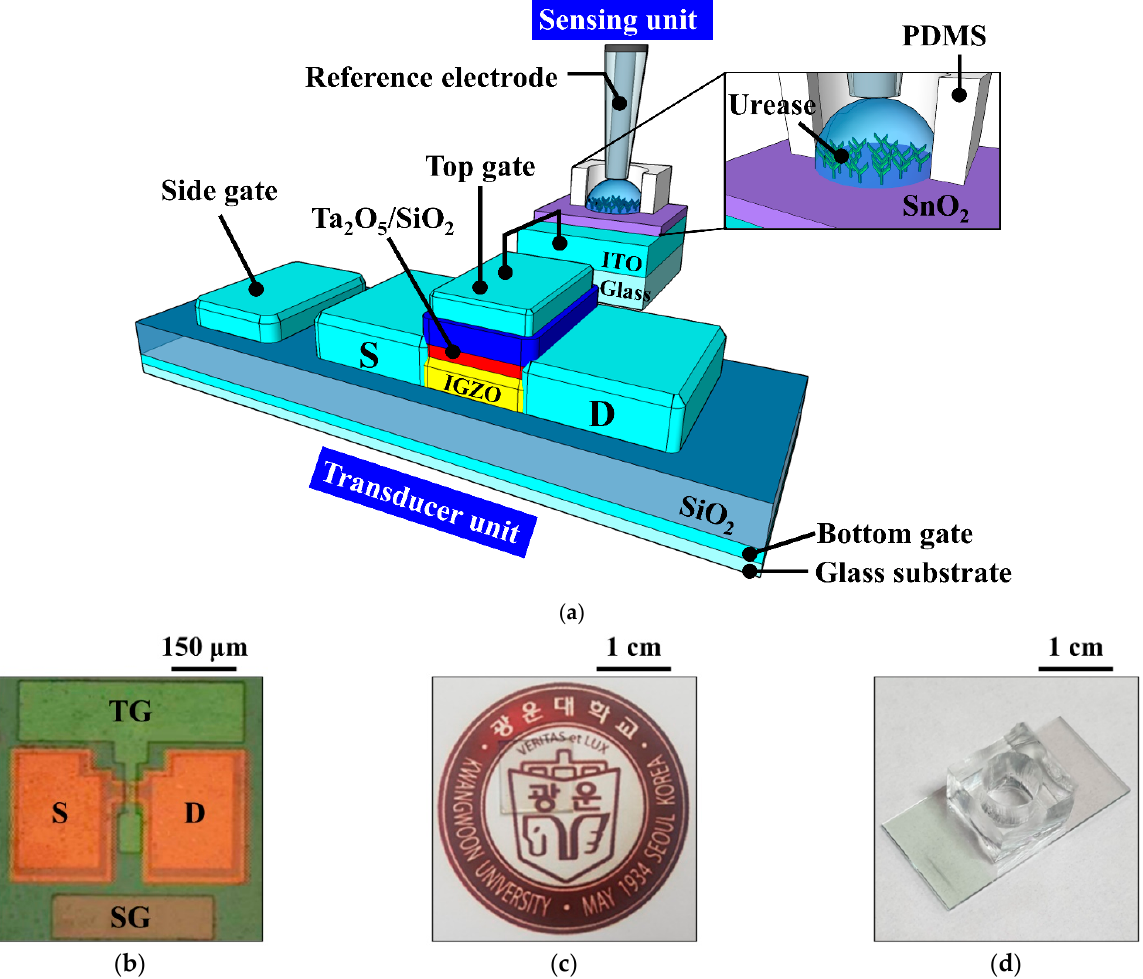
Figure 2. ( a ) Schematic diagram of the urea-EnFET sensor configured by the triple-gate a-IGZO TFT and urease-immobi- lized SnO 2 sensing membrane EG; ( b ) optical microscopy and ( c ) photographic images of the fabricated triple-gate a-IGZO TFT; and ( d ) photographic image of the urease-immobilized SnO 2 sensing membrane EG.